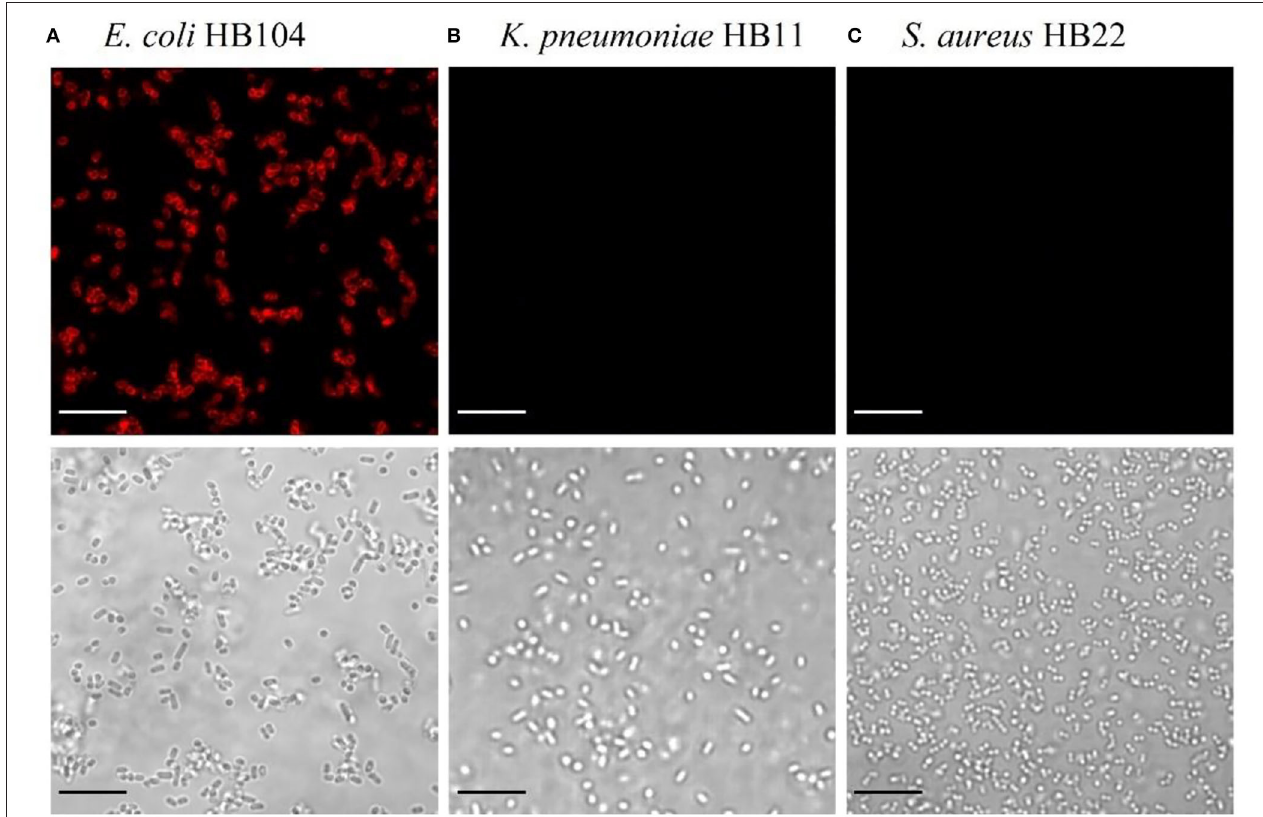
FIGURE 1 | Functional analysis of the RBP mCherry-Gp17. Fluorescence microscopy images after incubation of mCherry-Gp17 with bacterial cells of the target E. coli HB104 (A) and the non-target K. pneumoniae HB11 (B) and S. aureus HB22 (C) . The scale bar represents 10 µ m.